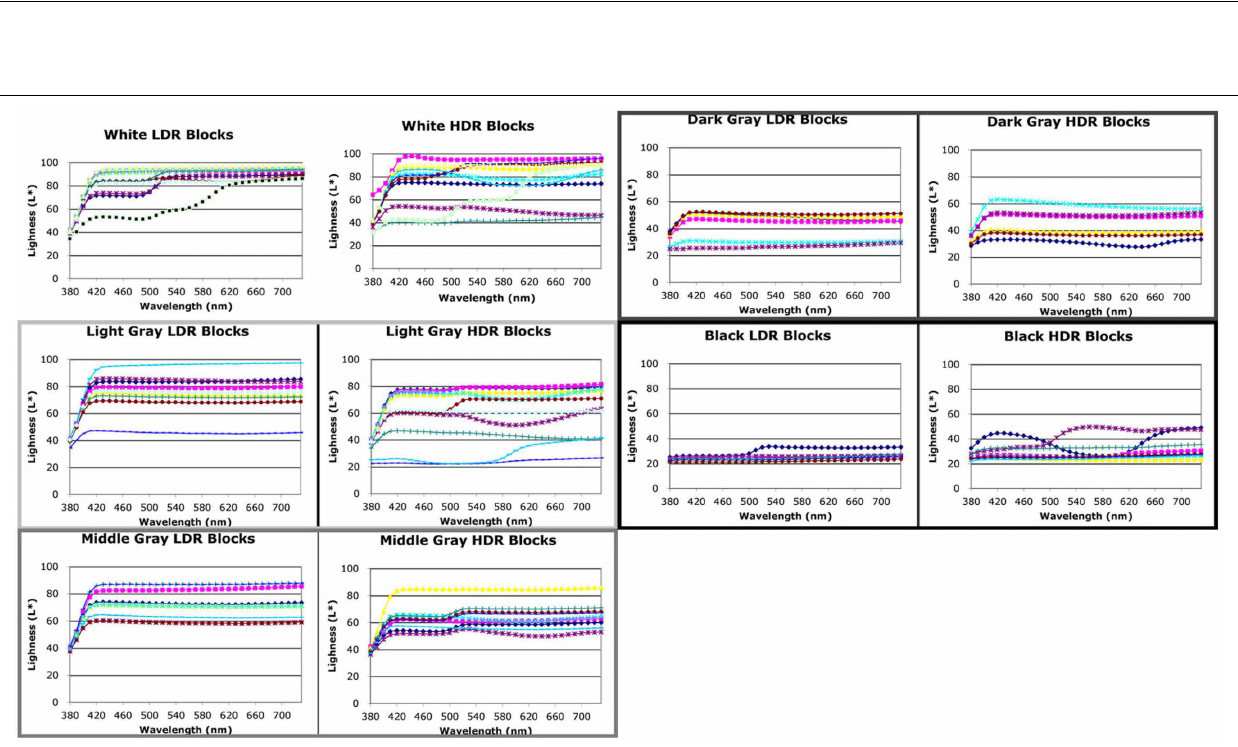
FIGURE 8 | Reflectance spectra scaled by L ∗ of red, green, blue, cyan, magenta, and yellow facets measured from watercolor LDR and HDR paintings.